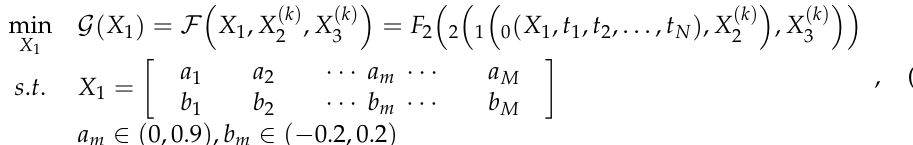
Figure 5. PASR values of different NLFM parameters under group 2 of sub-chirp rate PM code matrix and sub-chirp sequence code matrix.